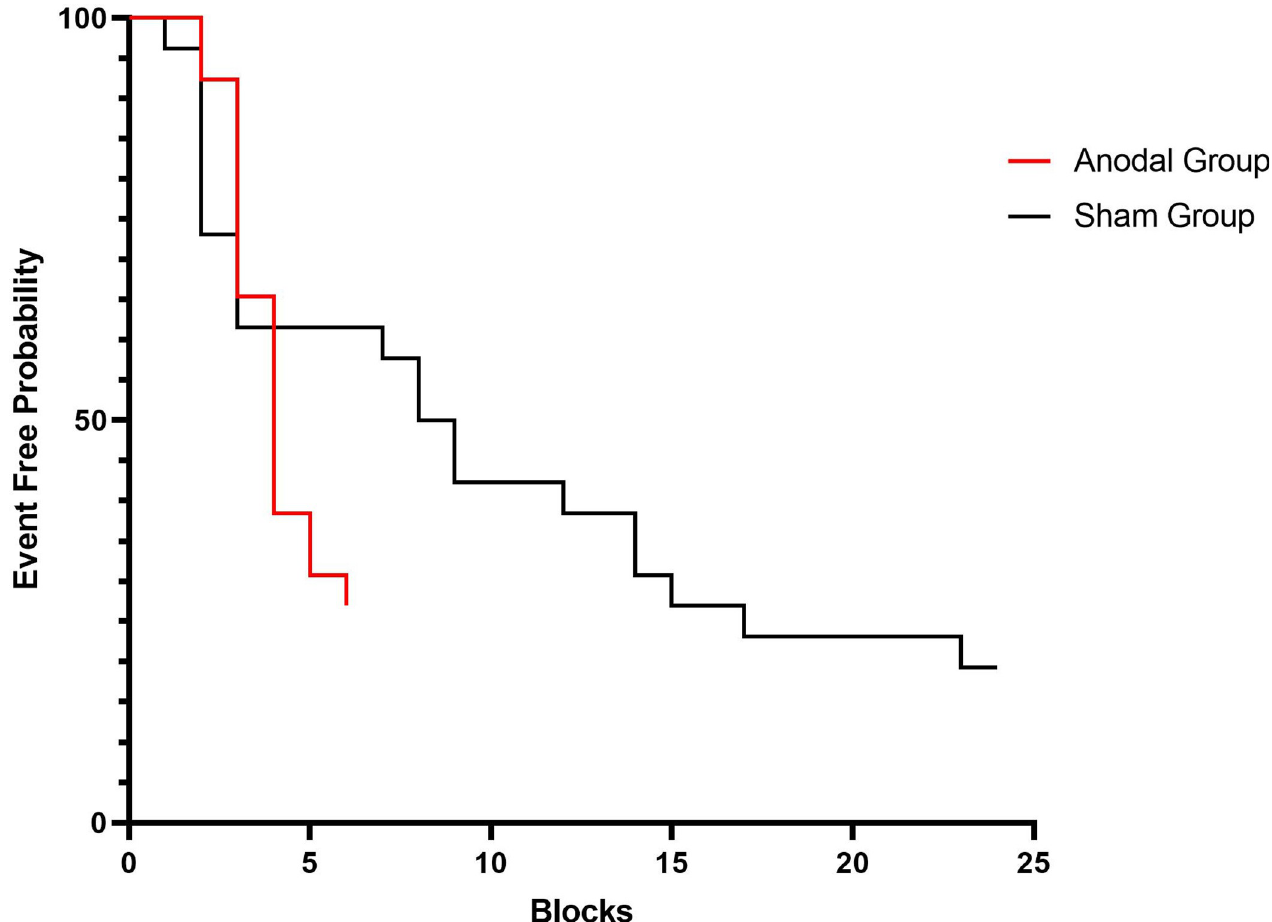
Fig 4. Learning probability. The y-axis corresponds to the percentage of participants who were unable to complete the event. The x-axis corresponds to the number of blocks of practice. At the start of the study, 100% of participants did not reach the event (i.e. y-axis “Event free probability” = 100%); this percentage drops as the study progresses over time. Fifty percent (i.e. y-axis “Event free probability” = 50%) of the anodal group (red line) completed the event by 4 blocks (i.e. x-axis “Blocks” = 4), whereas for the sham group (black line), 50% of participants completed the event by 8 blocks. These two curves are significantly different from each other ( χ 2 = 9.117, p =